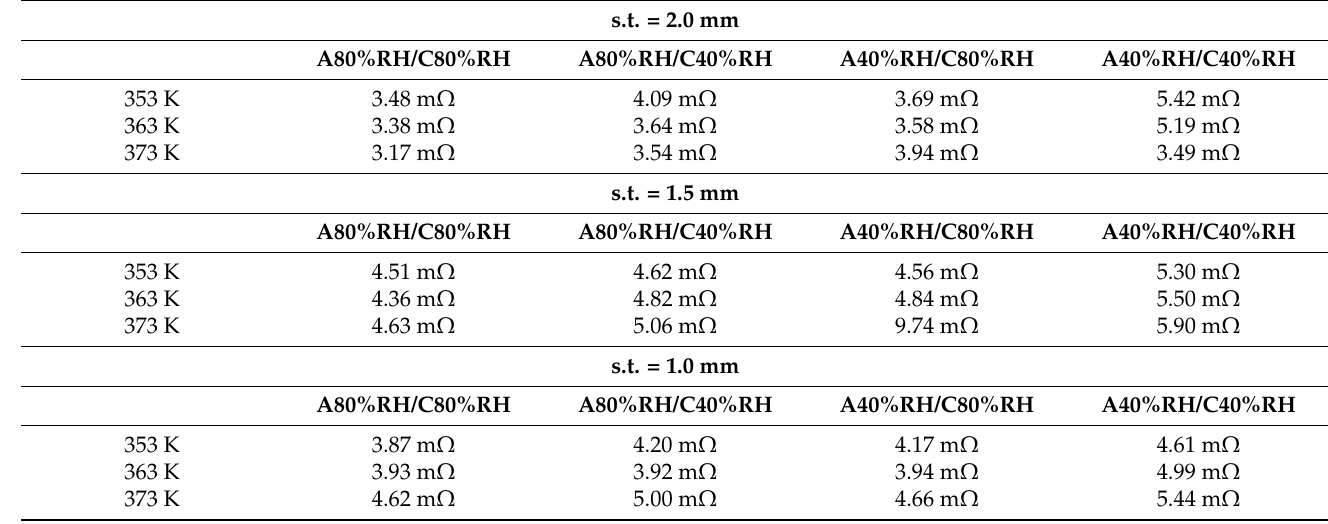
Table 5. Comparison of the ohmic resistance among various s.t. changing T ini and RH of supply gas.